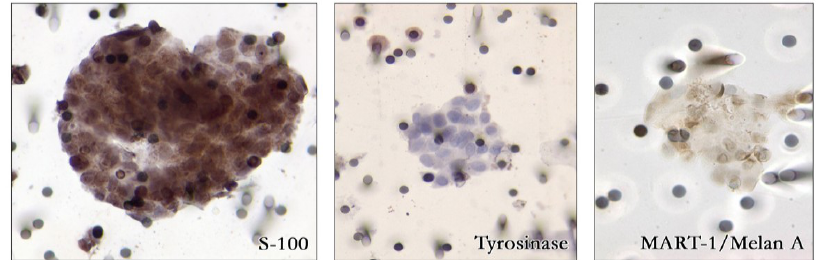
Figure 2. Immunohistochemical analysis of circulating tumor microemboli with S-100, tyrosinase and Mart-1/Melan A antibodies identifying circulating melanoma cells.